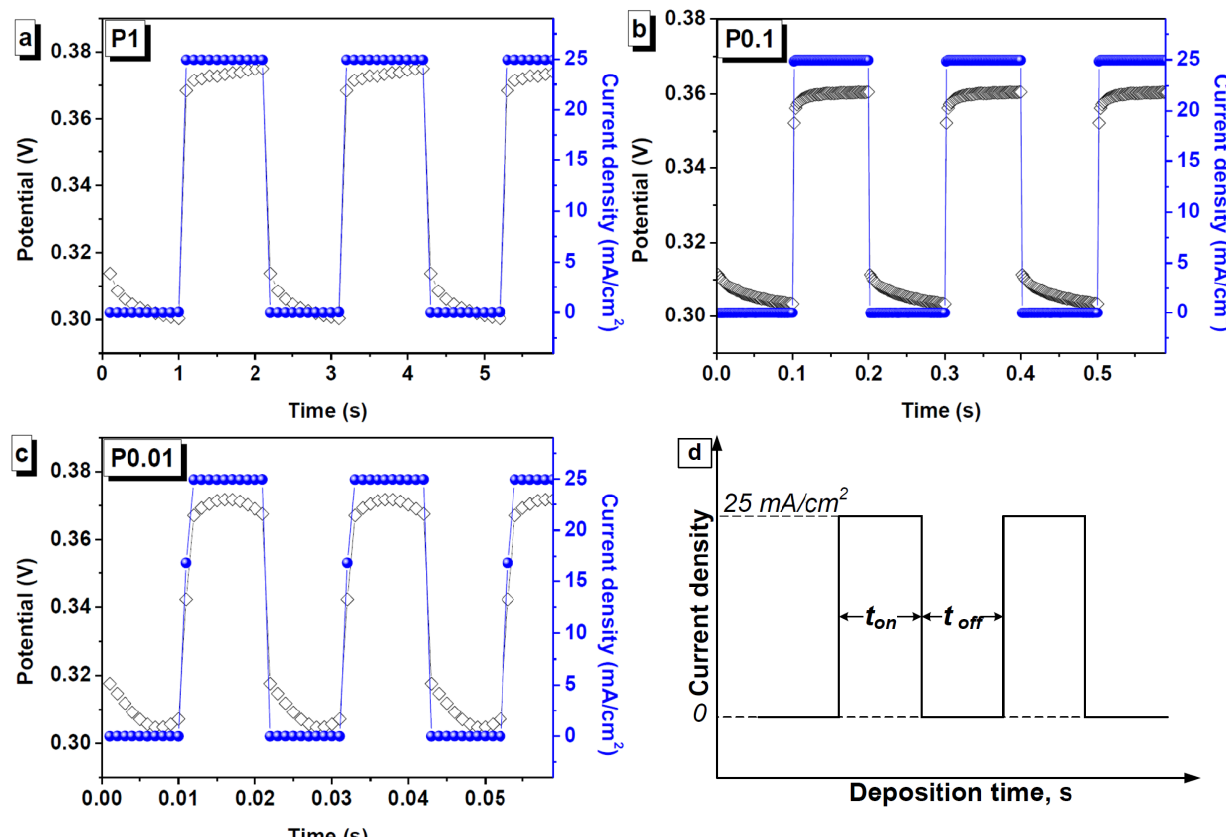
Figure 1. Change in current density and potential during pulsed deposition of the ( a ) P1, ( b ) P0.1, and ( c ) P0.01 shields, as well as ( d ) a schematic representation of pulsed deposition.